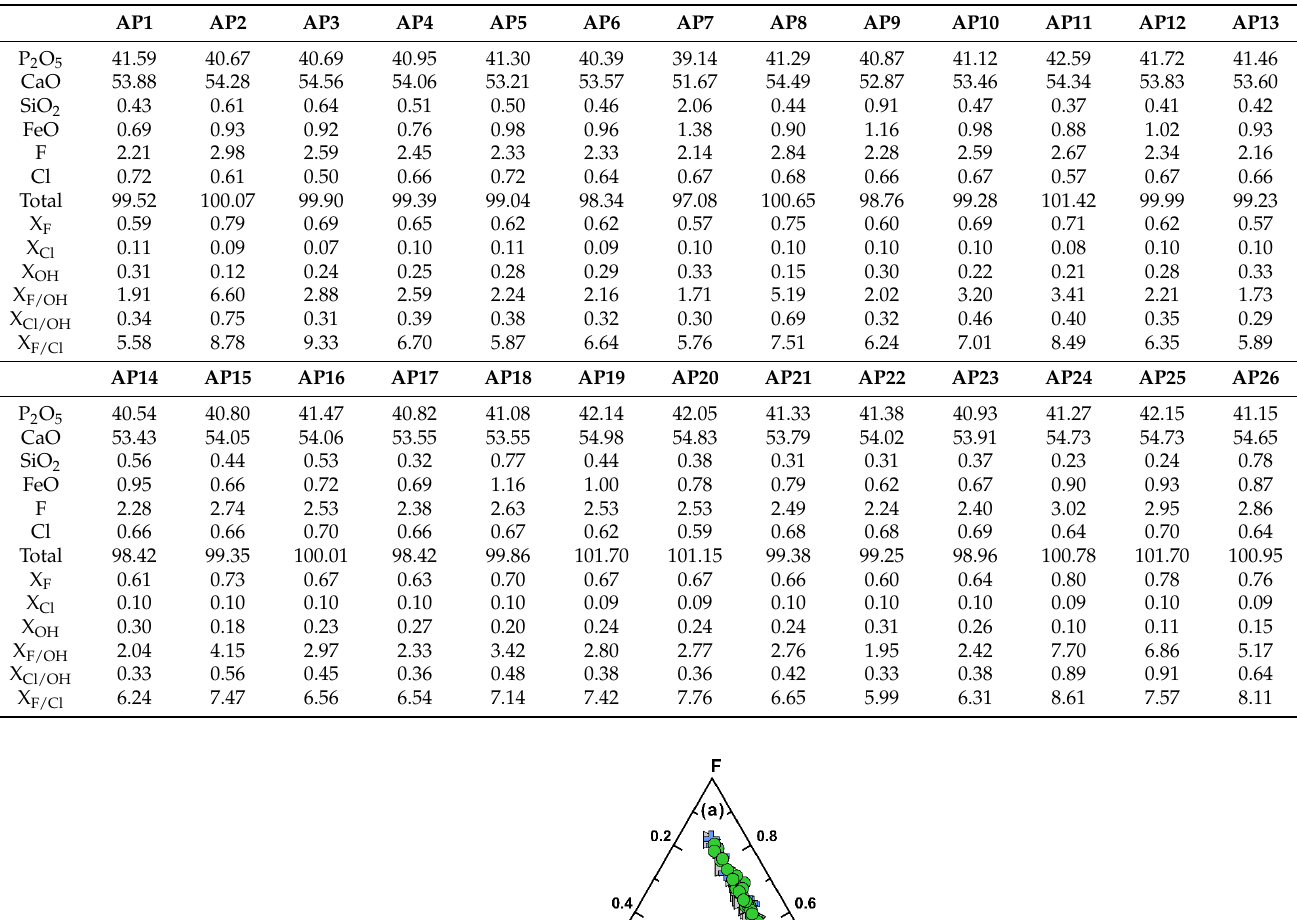
Table 2. Major and volatile element analyses of the amphibole-hosted apatite inclusions (wt.%).